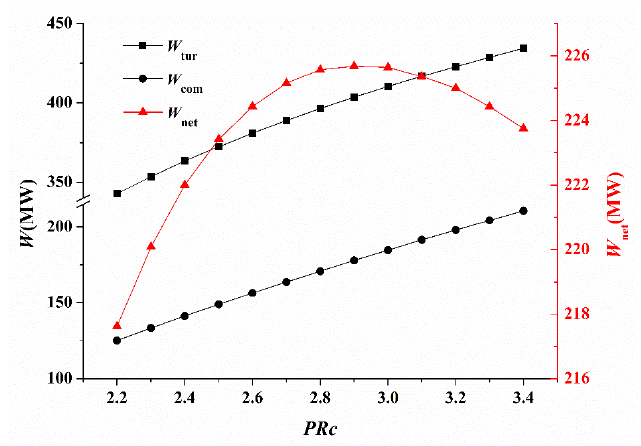
Figure 3. Variation trends of W tur , W com, and W net with PRc for the sCO 2 /LiBr-H 2 O AHP system.